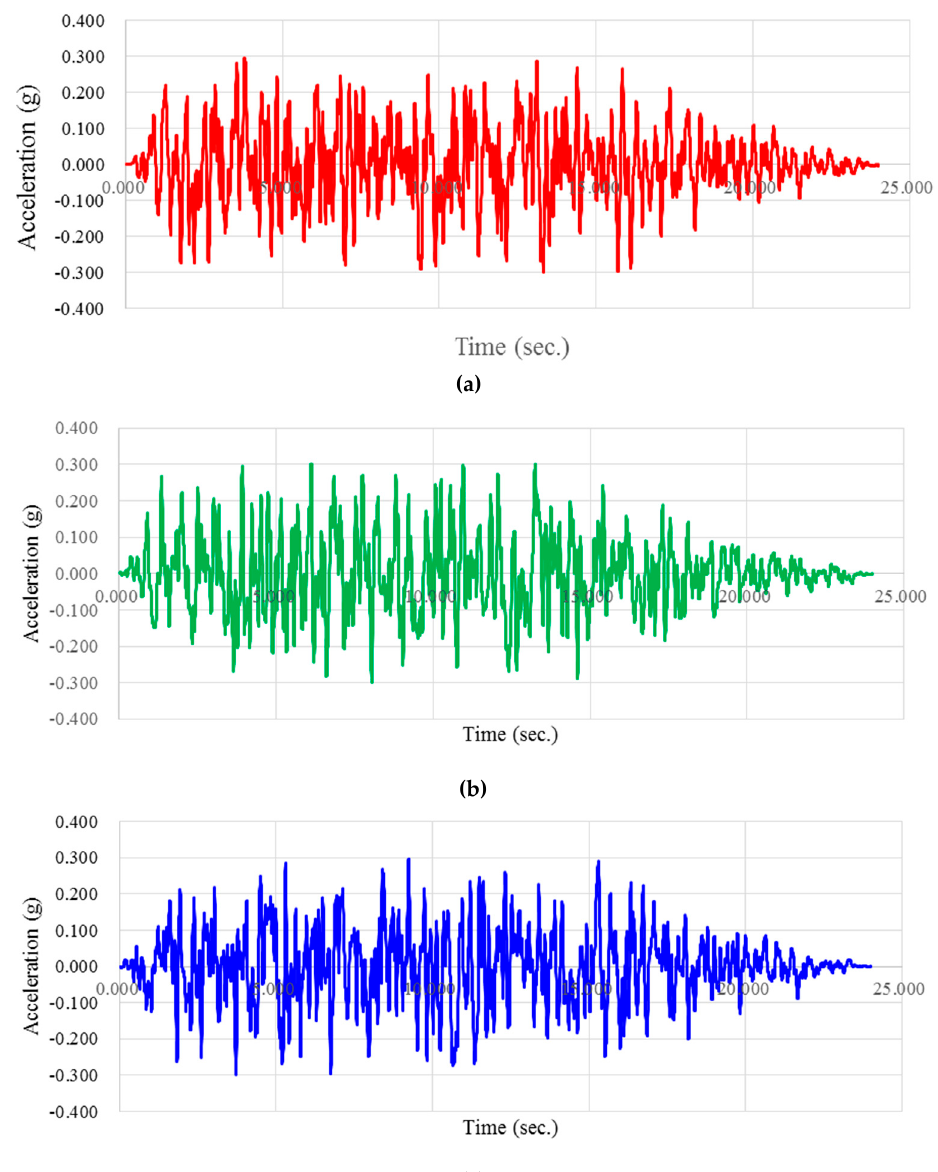
Figure 2. Seismic design response spectrum and expression of the TMD installation target modes